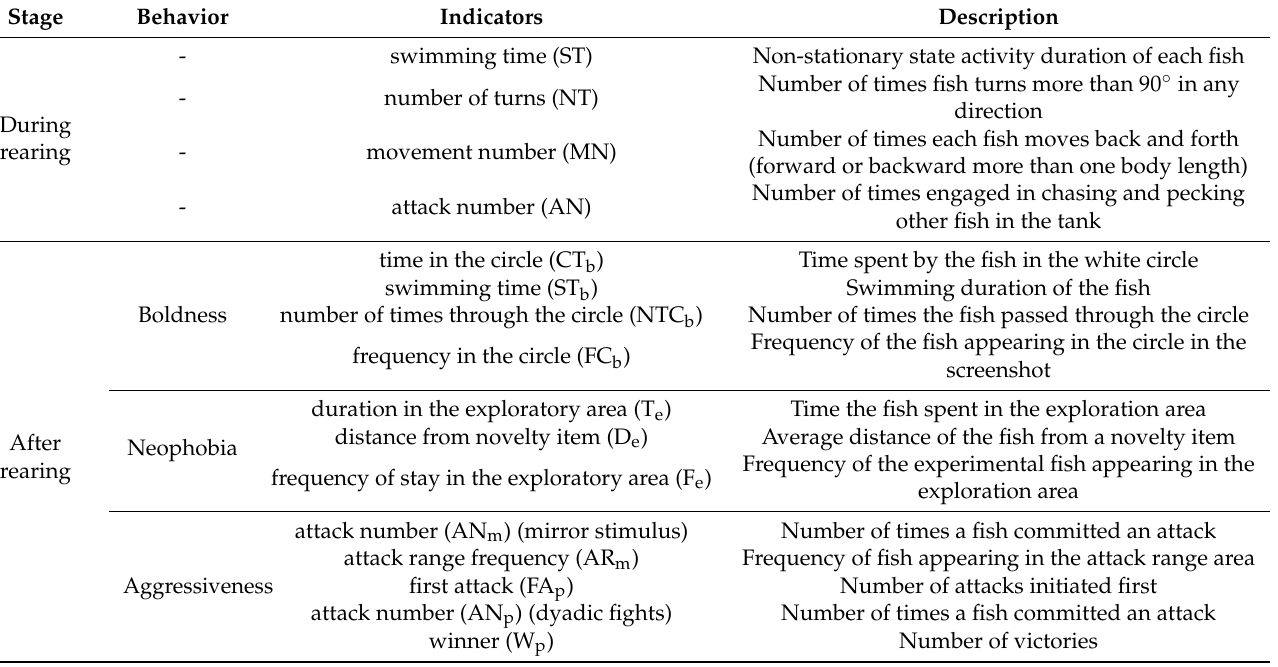
Table 1. Behavior measurement indicators and descriptions of the experiments with black rockfish ( Sebastes schlegelii Hilgendorf, 1880) in two experimental stages: during rearing and after